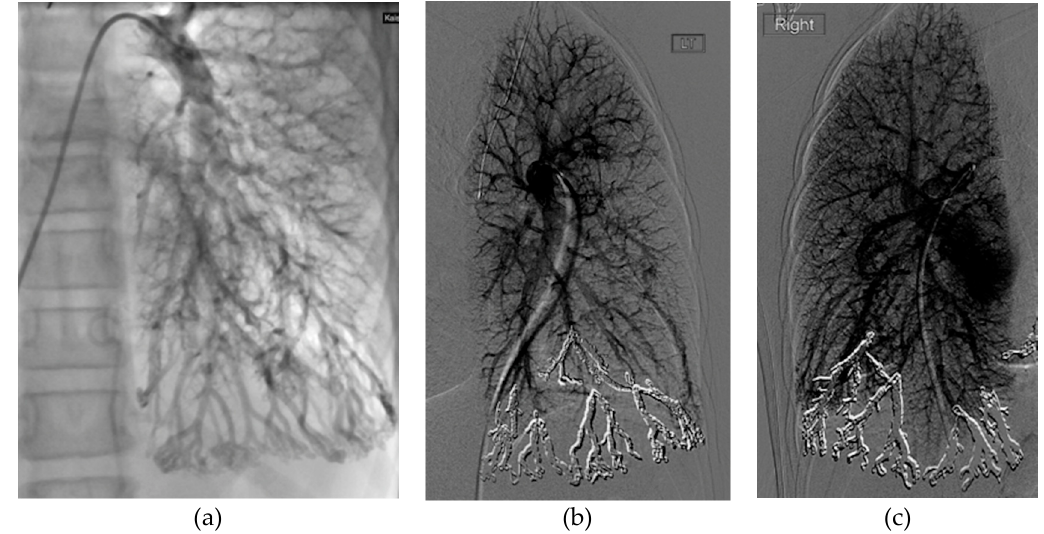
Figure 4. 9-year-old female with genetically confirmed HHT, mild growth and developmental delay, presenting with dyspnea on exertion and chronic hypoxemia (baseline oxygen saturation of 60–80%) requiring supplemental oxygen. CT chest (not shown) showed diffuse PAVMs affecting all segments of both lungs. ( a ) Initial pulmonary angiogram of the left lung demonstrates diffuse PAVMs, most pronounced in the basal left lower lobe and lingula. ( b ) Final pulmonary angiogram of the left lung following peripheral-to-central embolization of the left lower lobe and lingula with implantation of 20 coils. ( c ) Final pulmonary angiogram of the contralateral right lung, performed 1 month after the left-sided embolization. Similar to the left lung, embolization was performed of the dominant PAVMs of the right lower lobe basilar segments. Despite the extensive embolization, the patient had no improvement in baseline oxygen saturation or functional status.